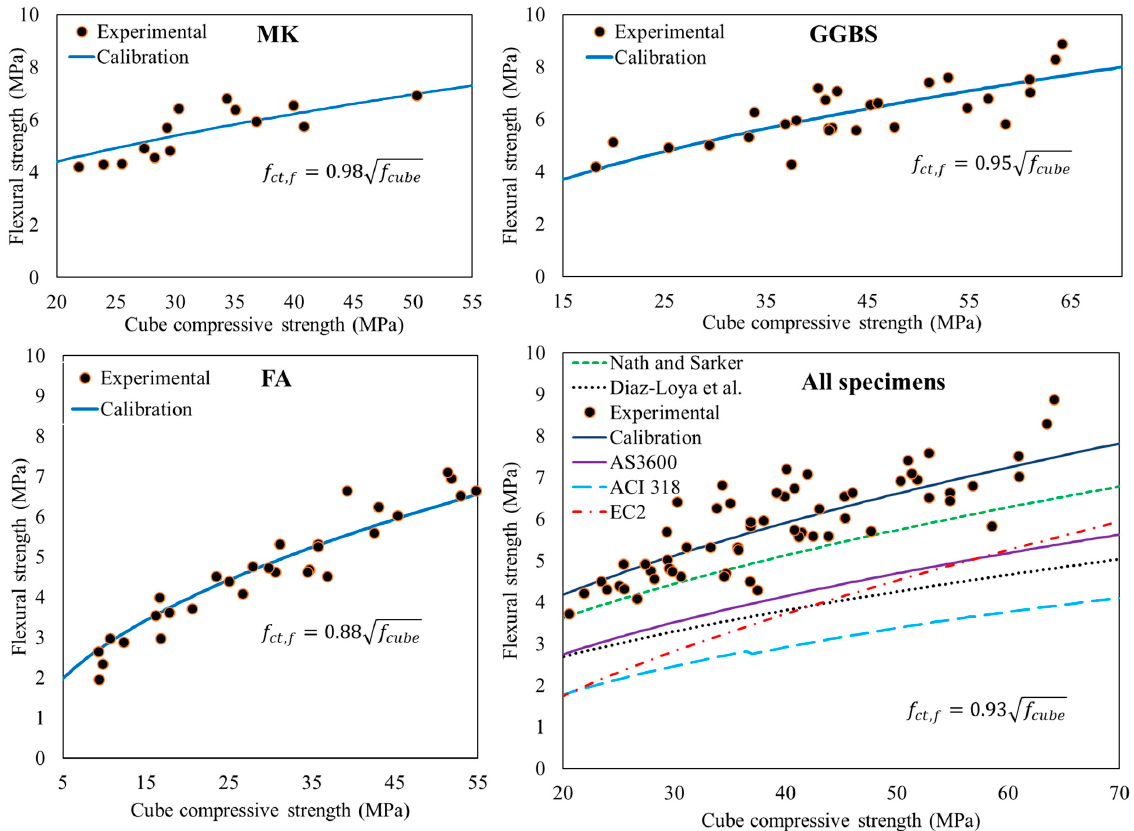
Figure 4. Comparison of experimental and predicted flexural strengths.